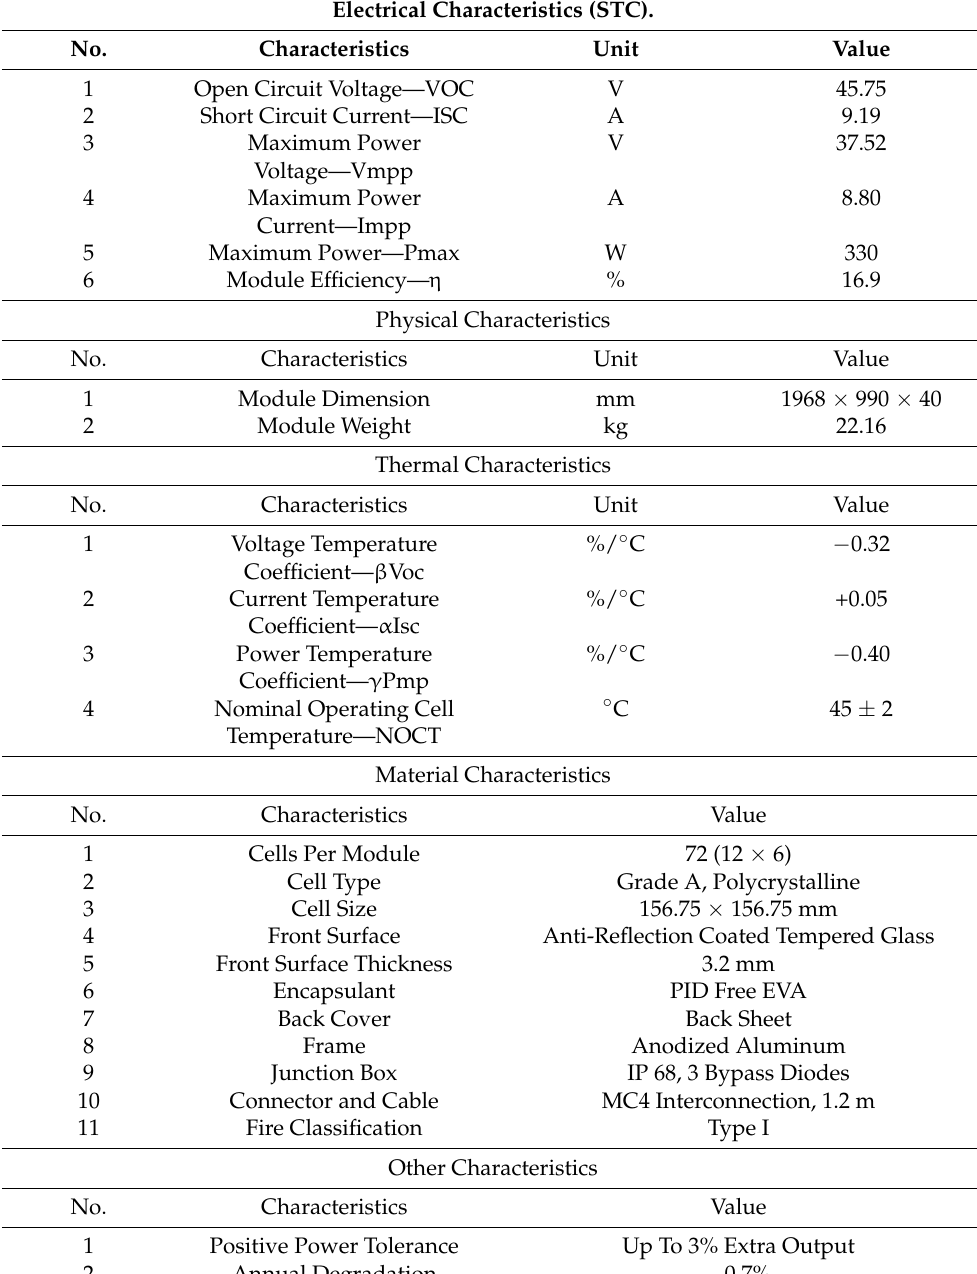
Table 5. Technical characteristics of the selected PV panel. Electrical Characteristics